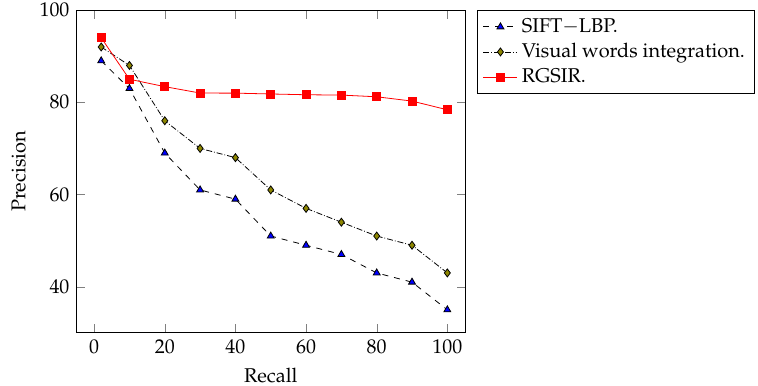
Figure 10. P - R curve obtained using Corel-1K image